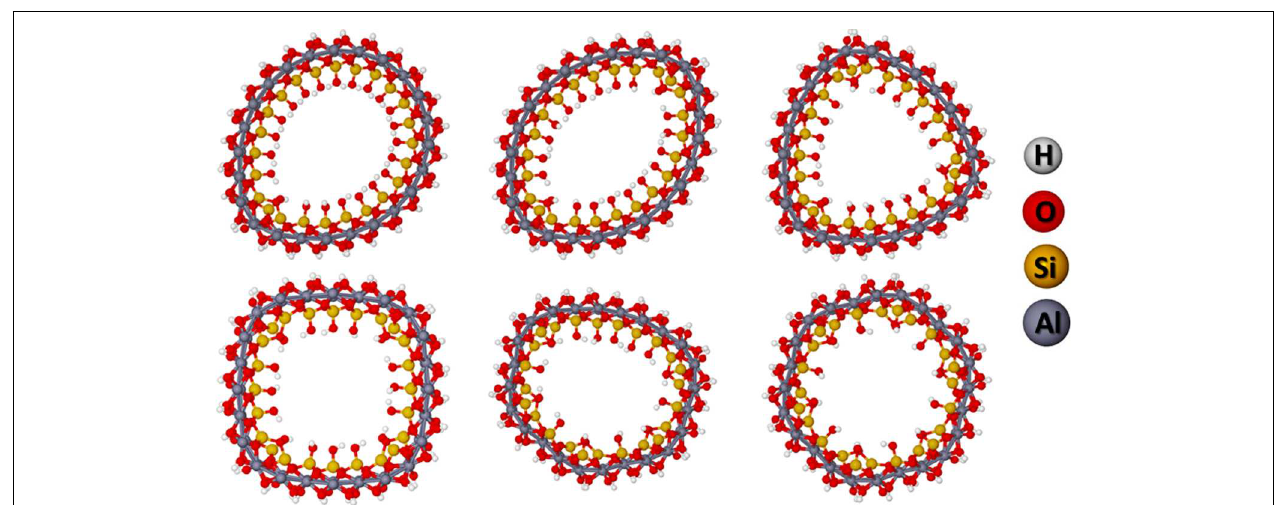
FIGURE 7 | Optimized structures of the dehydroxylated (12,0) imogolite .